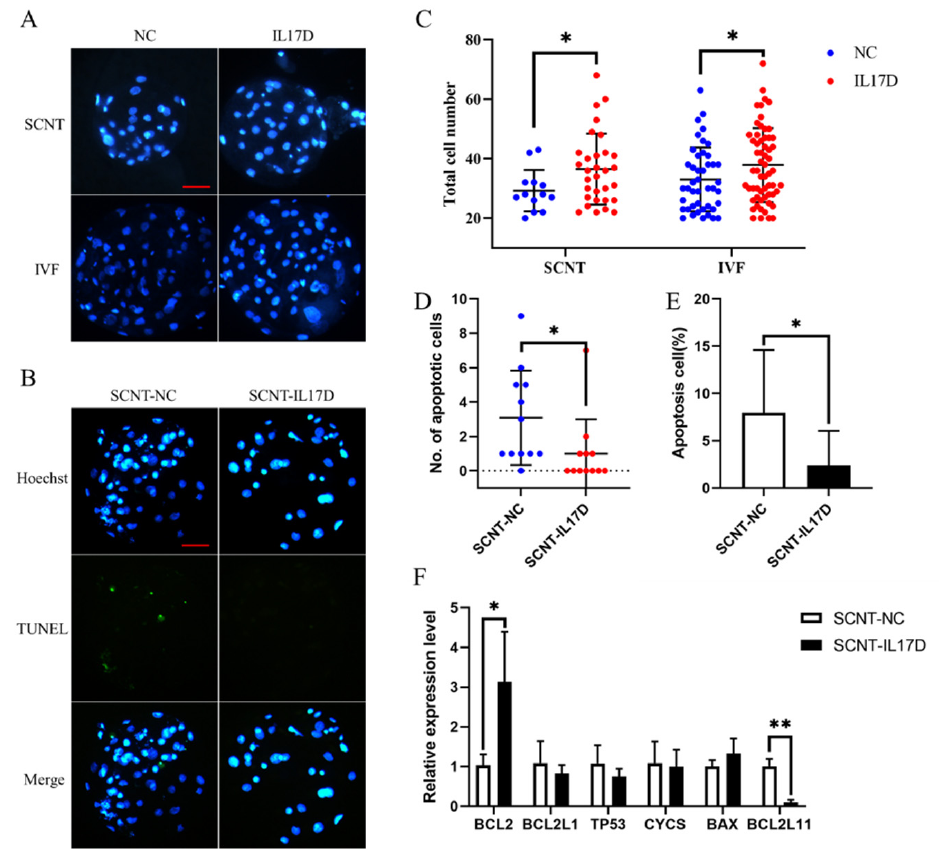
Figure 2. Effect of IL17D treatment on apoptosis of SCNT and IVF embryos. ( A ) Nuclear staining of SCNT-NC, SCNT-IL17D, IVF-NC and IVF-IL17D embryos at blastocyst stage by Hoechst33342 (blue). Bar = 100 µm. ( B ) TUNEL assay of SCNT-NC, SCNT-IL17D embryos at blastocyst stage. Bar = 100 µm. ( C ) Total cell number of SCNT-NC, SCNT-IL17D, IVF-NC and IVF-IL17D embryos at blastocyst stage. ( D ) Number and ( E ) proportion of apoptotic cells of SCNT-NC, SCNT-IL17D embryos at blastocyst stage. ( F ) The mRNA expression level of apoptosis-related genes of SCNT-NC and SCNT-IL17D embryos at blastocyst stage. Data were obtained from three independent replicates. Values were presented as mean ± SEM. * and ** means p < 0.05 and p < 0.01, respectively.